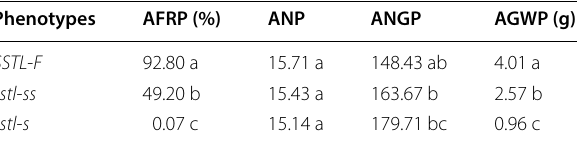
Table 1 Yield component analysis of sstl progeny